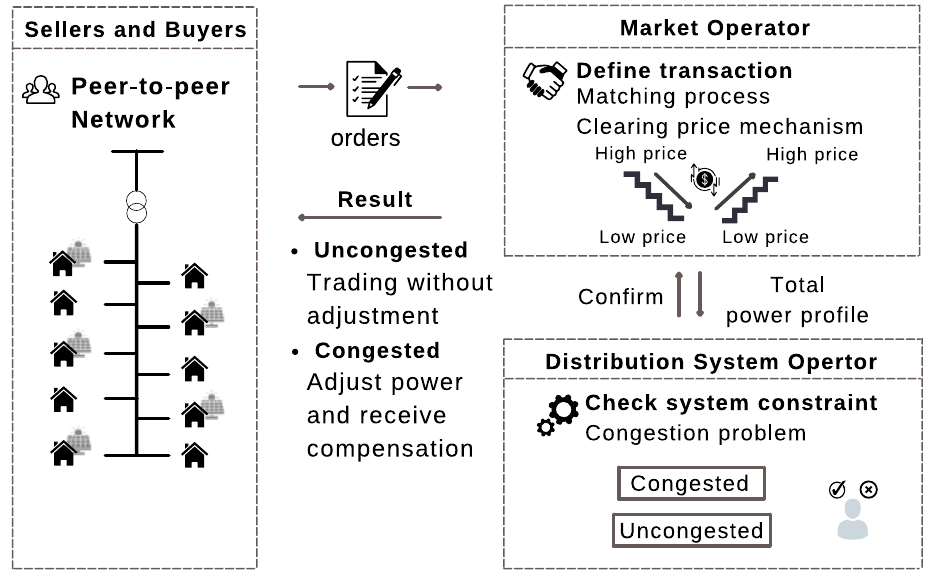
Figure 1. The role of players and overview processes in P2P community-based